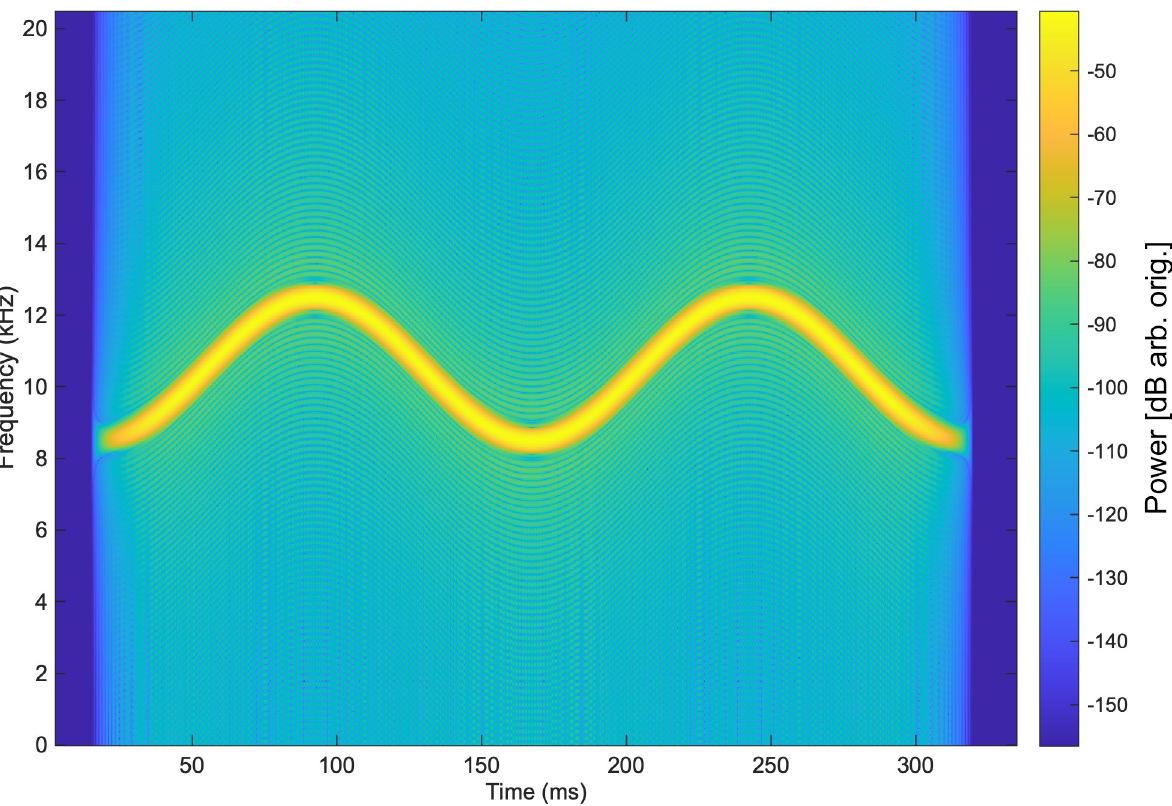
tonals were created for each permutation of table parameter values, as described below. To construct a tonal’s waveform, we began with an instantaneous frequency, f ( t ), that described a goal time-frequency (or spectrographic) trace, for instance the trace shown in Fig 3. For sim- plicity, and consistent with the parameters typically used to describe dolphin whistles, we approximated dolphin whistles as sinusoidal traces in spectrographic space—thus f ( t ) was always a sinusoid. Based on the standard definition of the instantaneous frequency as